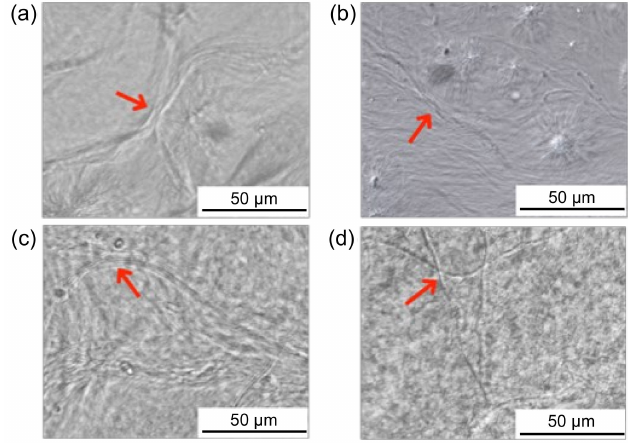
Figure 1. Optical micrographs of the hydrogels ( a – c ) and organogel ( d ): ( a ) hexadecyltrimethylammonium bromide (CTAB), ( b ) hexadecyltrimethylammonium chloride (CTAC), ( c ) hexadecylpyridinium chloride CPC, and ( d ) binary n-decane / 12-hydroxyoctadecanoic acid (12-HOA) systems (concentration C 12-HOA = 3.0 wt.%). The red arrows indicate the aggregated fibers forming thicker